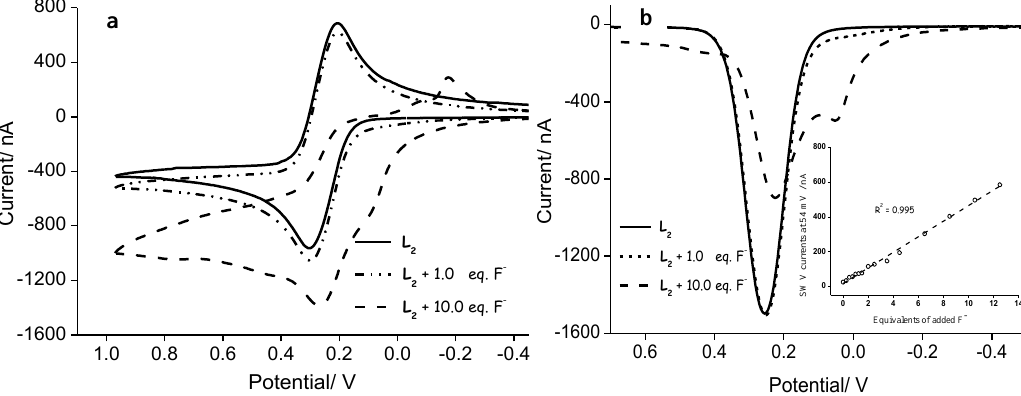
Figure 4. CV ( a ) and SWV ( b ) of receptor 2 in acetonitrile in the absence and presence of Bu 4 NF. Scan